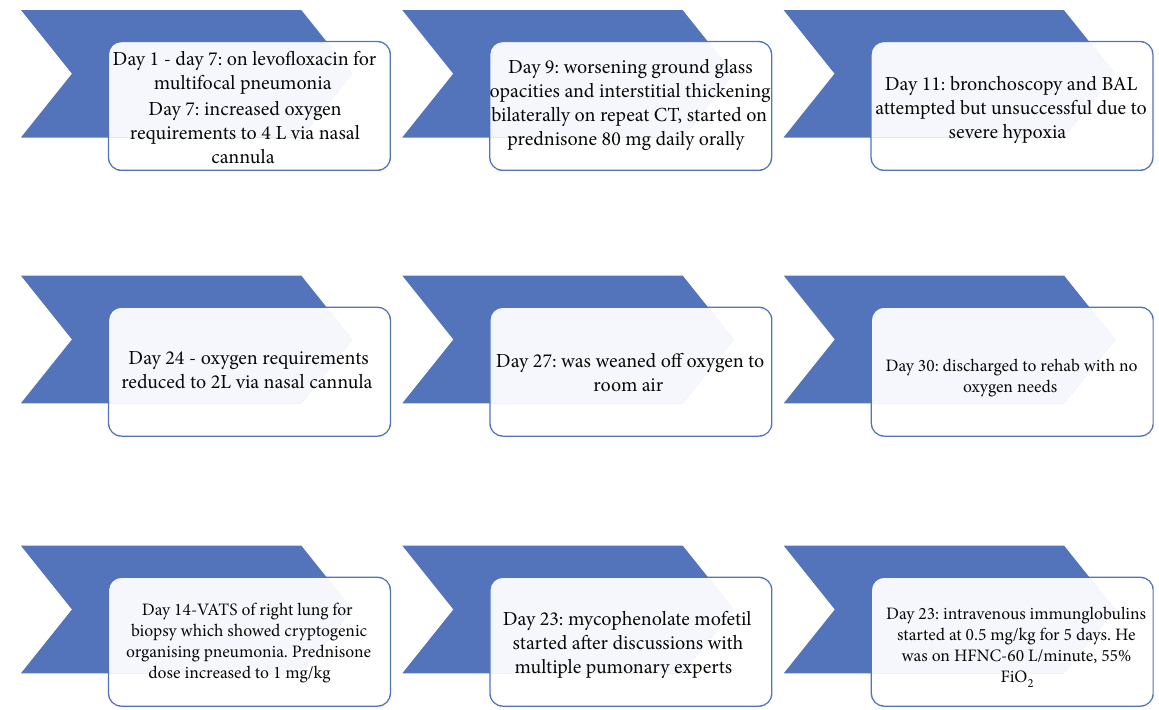
Figure 5: Flow chart summarizing hospital course of